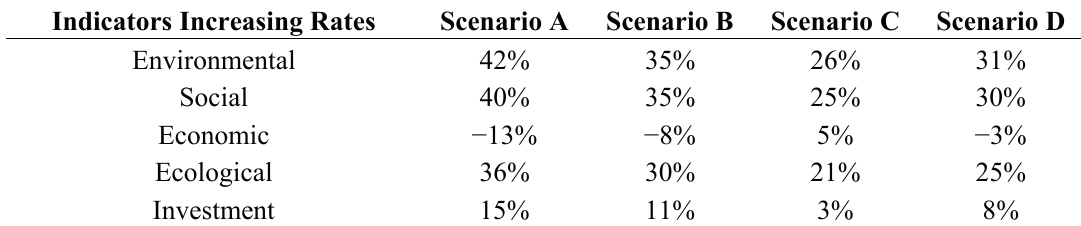
Table 12. Evaluation indicator increasing rates of each load reduction